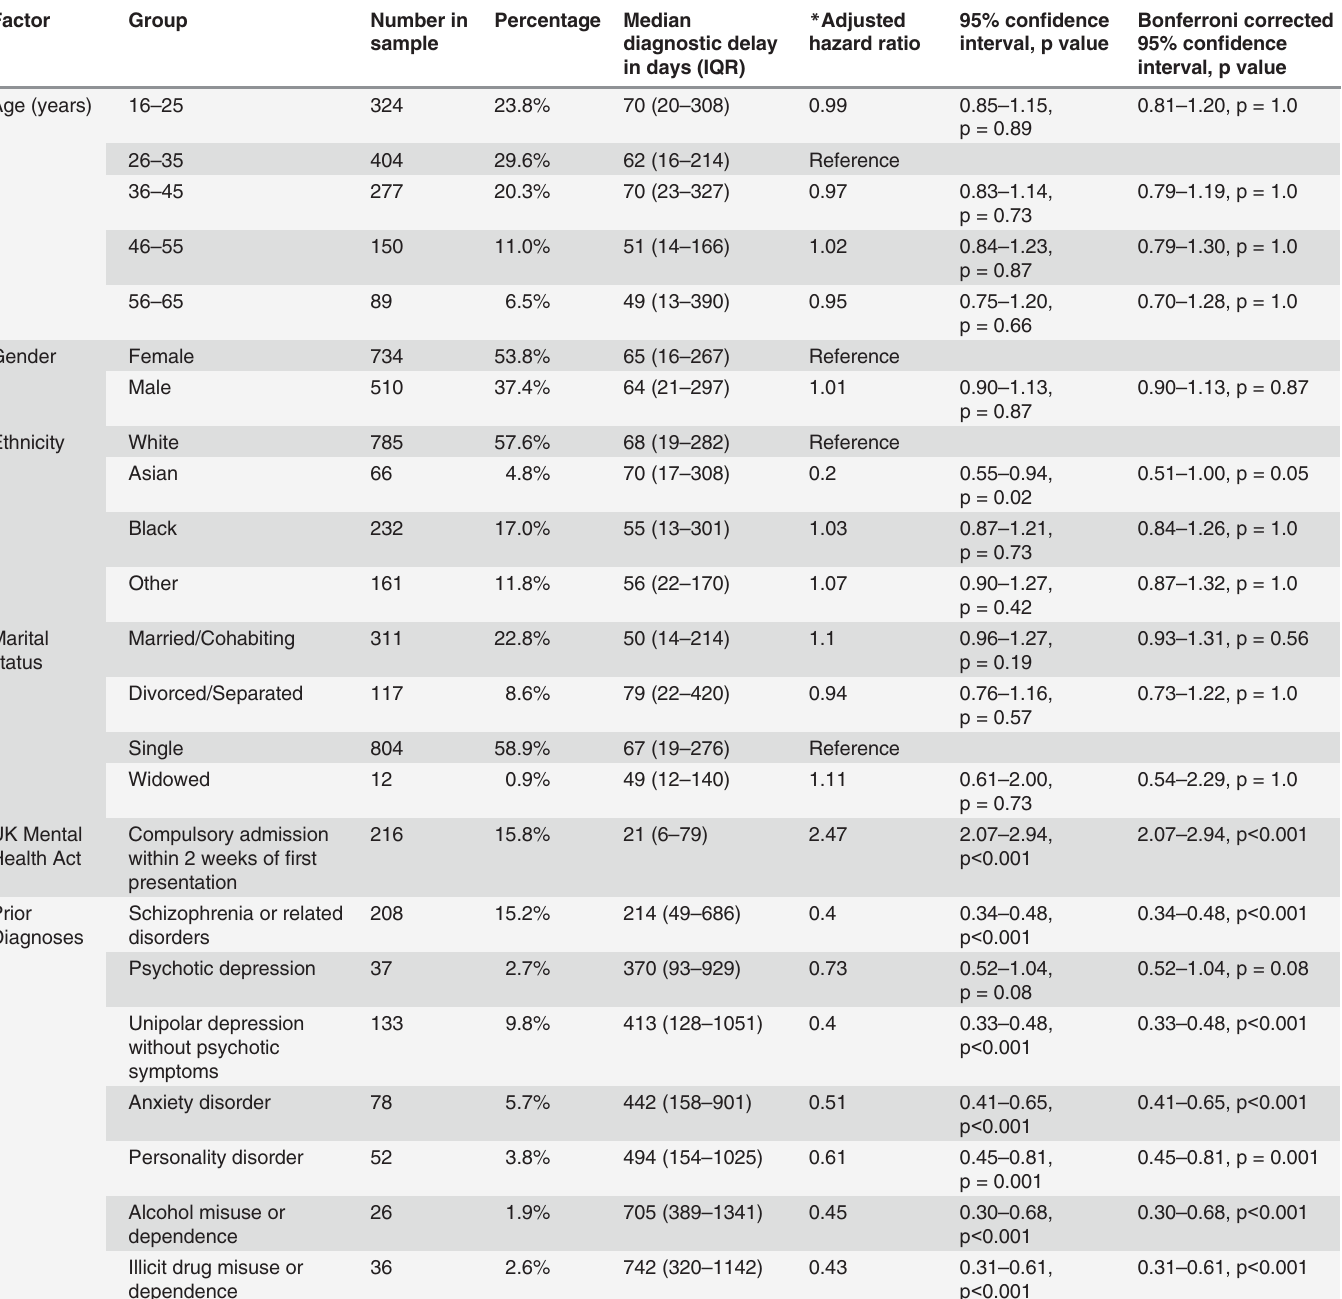
Table 4. Factors associated with bipolar disorder diagnostic delay only including participants with complete covariate data (n =